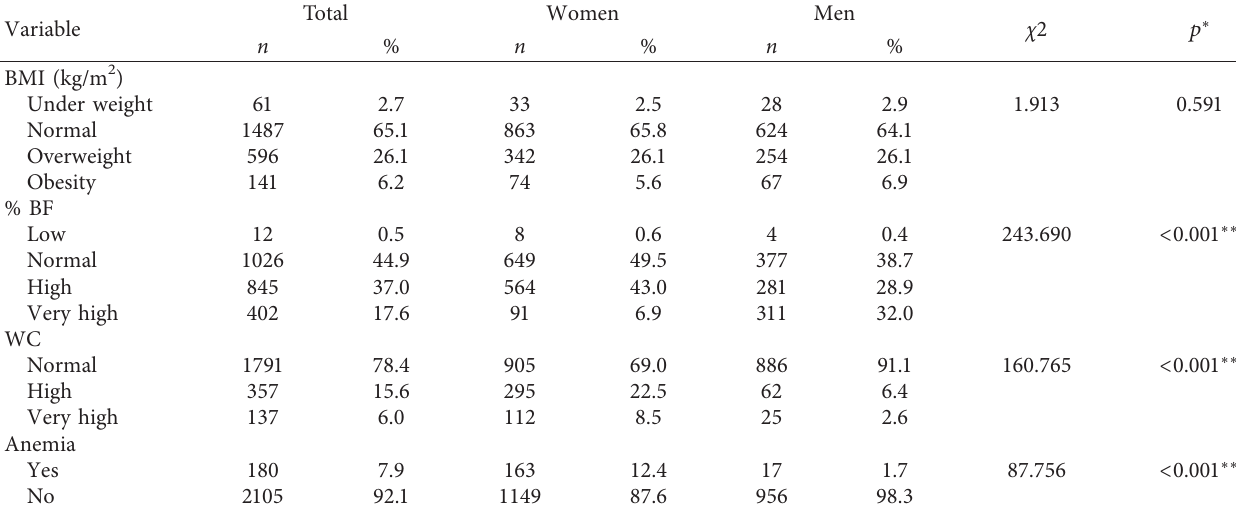
Table 3: BMI, % BF, WC, and anemia in female and male university students.